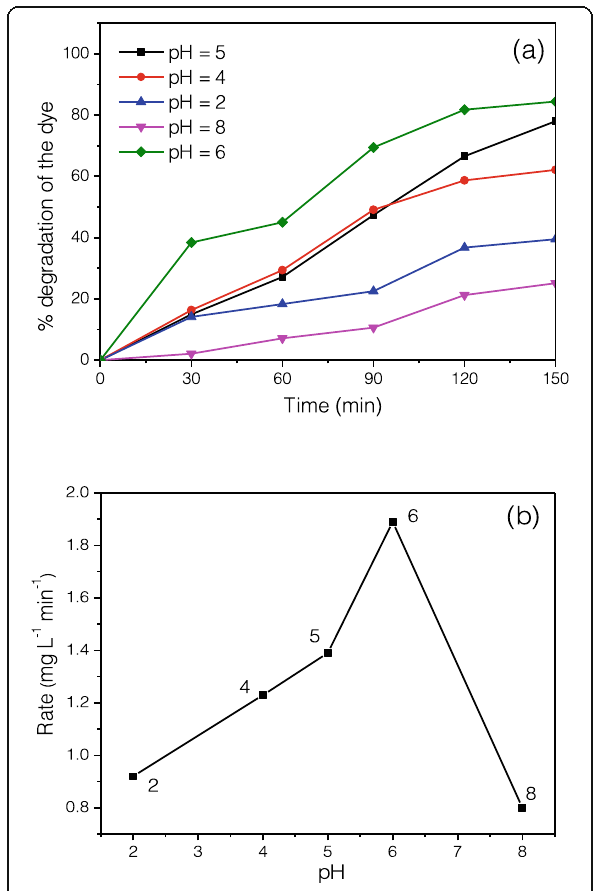
Fig. 9 ( a ) Effect of pH on the rate of degradation of AR 6A by ZBT 3 at catalyst dosage 50 mg L − 1 and AR 6A 10 mg L − 1 ( b ) rate of the degradation on effect of pH